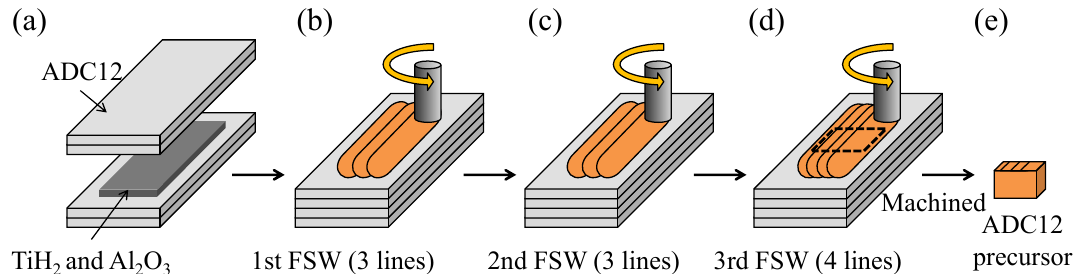
Figure 10. Schematic illustration of fabrication process of ADC12 foam precursor using FSW route. ( a ) The powders were placed along the path of the FSW tool; ( b ) FSW was conducted. 1st FSW; ( c ) 2nd FSW; ( d ) 3rd FSW; ( e ) Precursors were obtained.